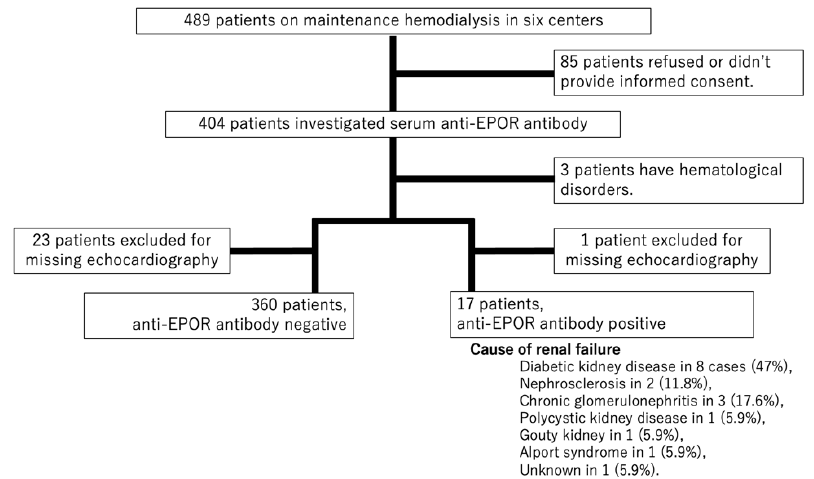
Figure 1. Patient selection flow chart.